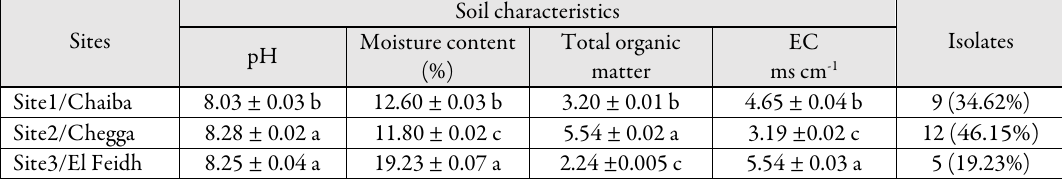
Table 2. Physicochemical properties of the sampled soils and number of isolates Sites